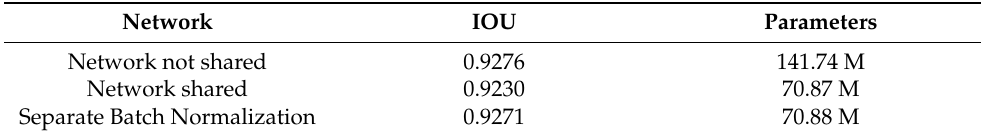
Table 3. Performance of Different Network Architectures.